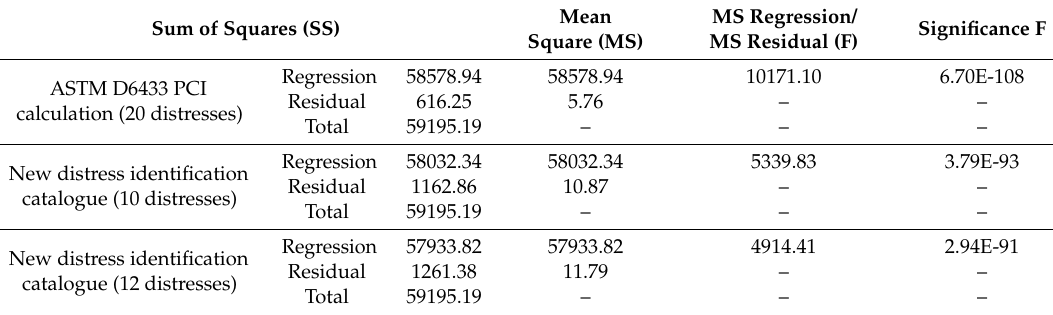
Table 7. Regression coefficient of the automated procedure for PCI